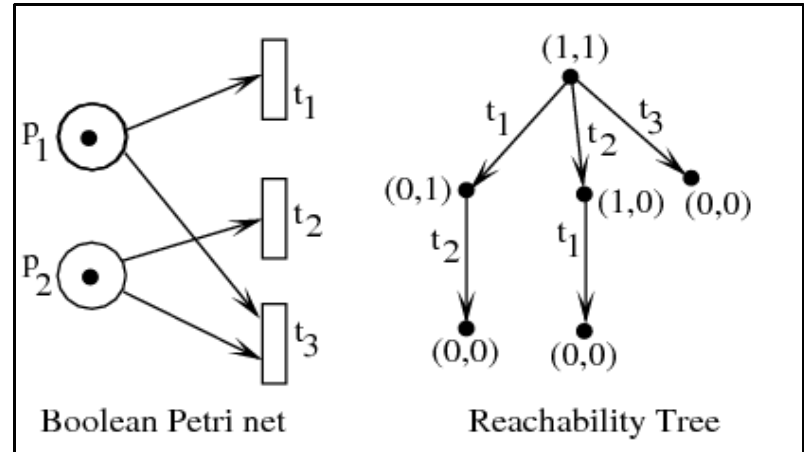
Figure 2. Boolean Petri net and its reachability tree